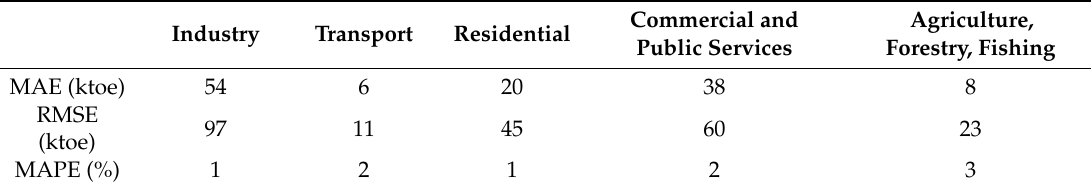
Figure 12. The comparison of the theoretical and actual values of final electricity consumption for agriculture, forestry, and fishing sectors, ktoe, source: own study. Table 2. The forecast acceptability.